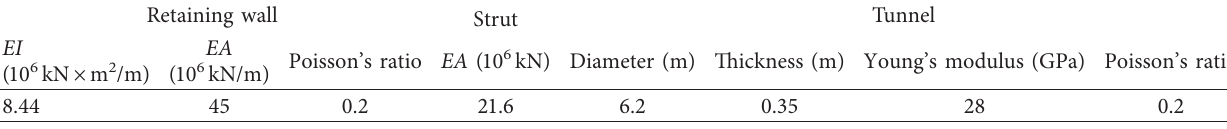
Figure 5: Schematics showing the excavation and tunnel geometries in the case study of Hangzhou, China. Table 4: Mechanical properties of excavation support and tunnel structures in the case study of Hangzhou, China.